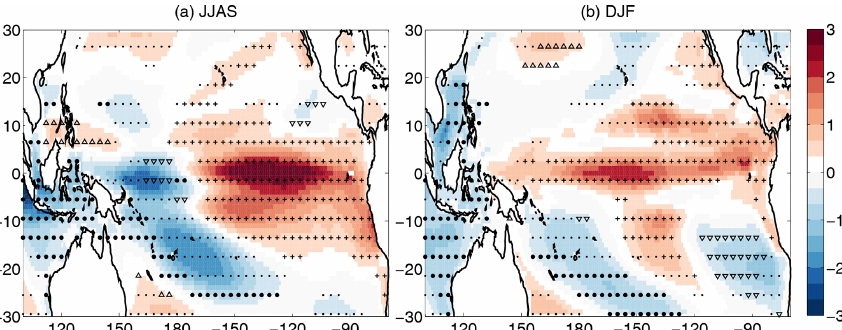
Figure 2. The slope of the linear fit (10 − 3 ◦ Cyr − 1 ) at each grid point of the (a) JJAS and (b) DJF regression maps from 1950 to 2100. Dots represent geographical locations where the trend is significant at the 95% level. In addition, (i) where the trend is positive and the regression coefficients are positive and significant at the 95% level in the temporal mean, “ + ” signs are displayed, (ii) where the trend is positive and the regression coefficients are negative and significant at the 95% level in the temporal mean, “ (cid:52) ” signs are displayed, (iii) where the trend is negative and the regression coefficients are positive and significant at the 95% level in the temporal mean, “ (cid:79) ” signs are displayed, and (iv) where the trend is negative and the regression coefficients are negative and significant at the 95% level in the temporal mean, “ • ” signs are displayed, respectively. For better visibility, the significance and direction of the trend is indicated at only every fourth grid